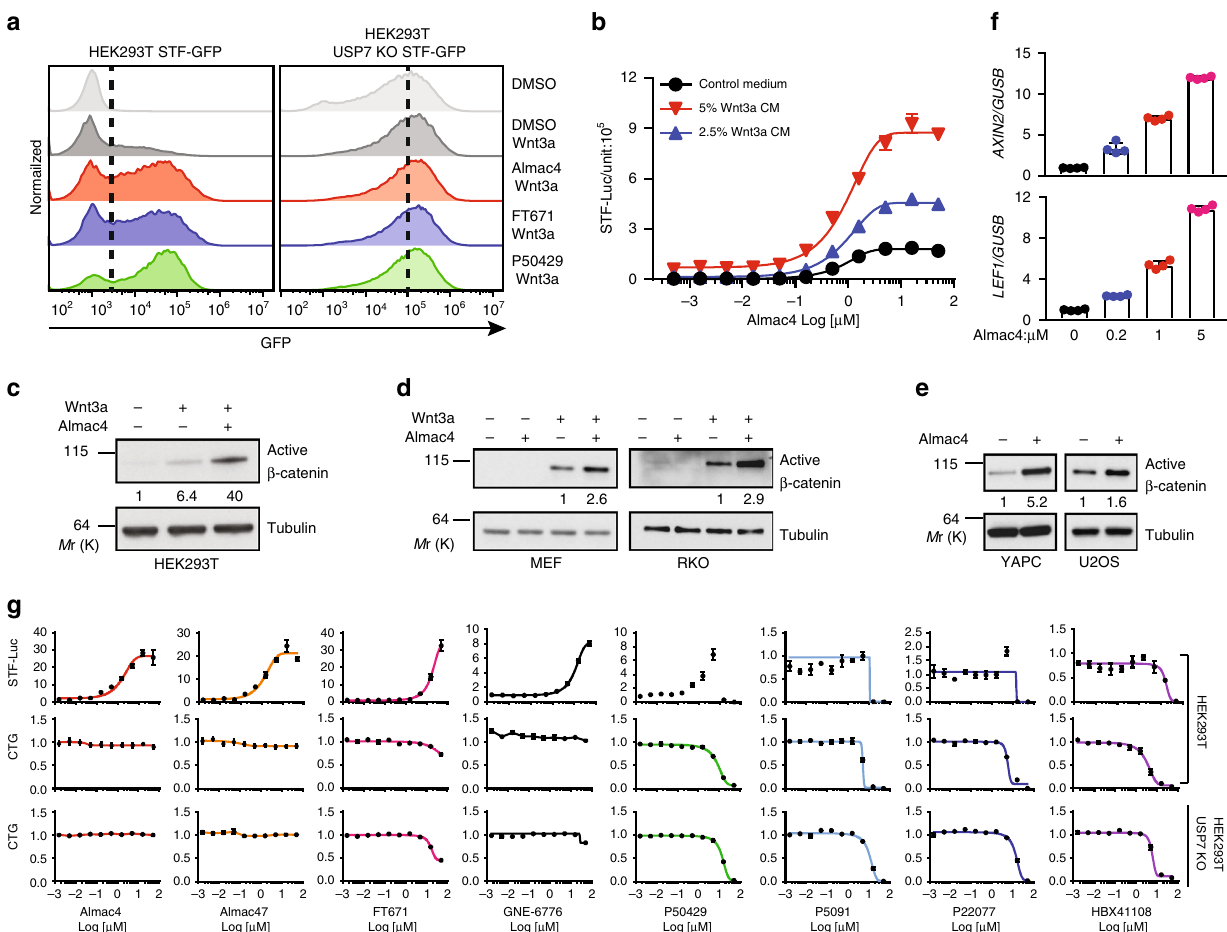
Fig. 2 USP7 inhibitors augment Wnt/ β -catenin signaling. a USP7 inhibitors potentiate Wnt3a-induced STF-GFP in HEK293T cells, but not in HEK293T USP7 KO cells, as determined by FACS assay. Wild-type and USP7 knockout STF-GFP reporter cells were pretreated with DMSO, 1 µ M Almac4, 5 µ M FT671 or 10 µ M P504290 for 24 h and stimulated with 10% Wnt3a CM overnight. b Almac4 increases STF-Luc activity in a dose-dependent manner in the presence or absence of exogenous Wnt3a in HEK293T cells. Error bars denote the SD between four replicates. c – e Almac4 enhances accumulation of active β -catenin. HEK293T, RKO and MEF cells were pretreated with DMSO or Almac4 (1 µ M for HEK293T and 2 µ M for RKO and MEF) for 24 h, and followed by overnight Wnt3a CM stimulation. YAPC and U2OS cells were treated with DMSO or 2 µ M Almac4 for 2 days. f Almac4 increases the expression of β -catenin target genes in a dose-dependent manner in YAPC cells. YAPC cells were treated with Almac4 at indicated doses for 2 days and total RNA was prepared for RT-PCR assay. Error bars denote the SD between four replicates. g HEK293T (top and middle panel) and HEK293T USP7 KO (bottom panel) cells were pretreated with increasing doses of USP7 inhibitors for 24 h, and stimulated with 5% Wnt3a CM overnight. STF-Luc reporter activity was measure by Bright-Glo assay and viability of cells was assessed using Cell Titer-Glo (CTG) assay. Source data for Fig. 2b, c, d, e, f, and g